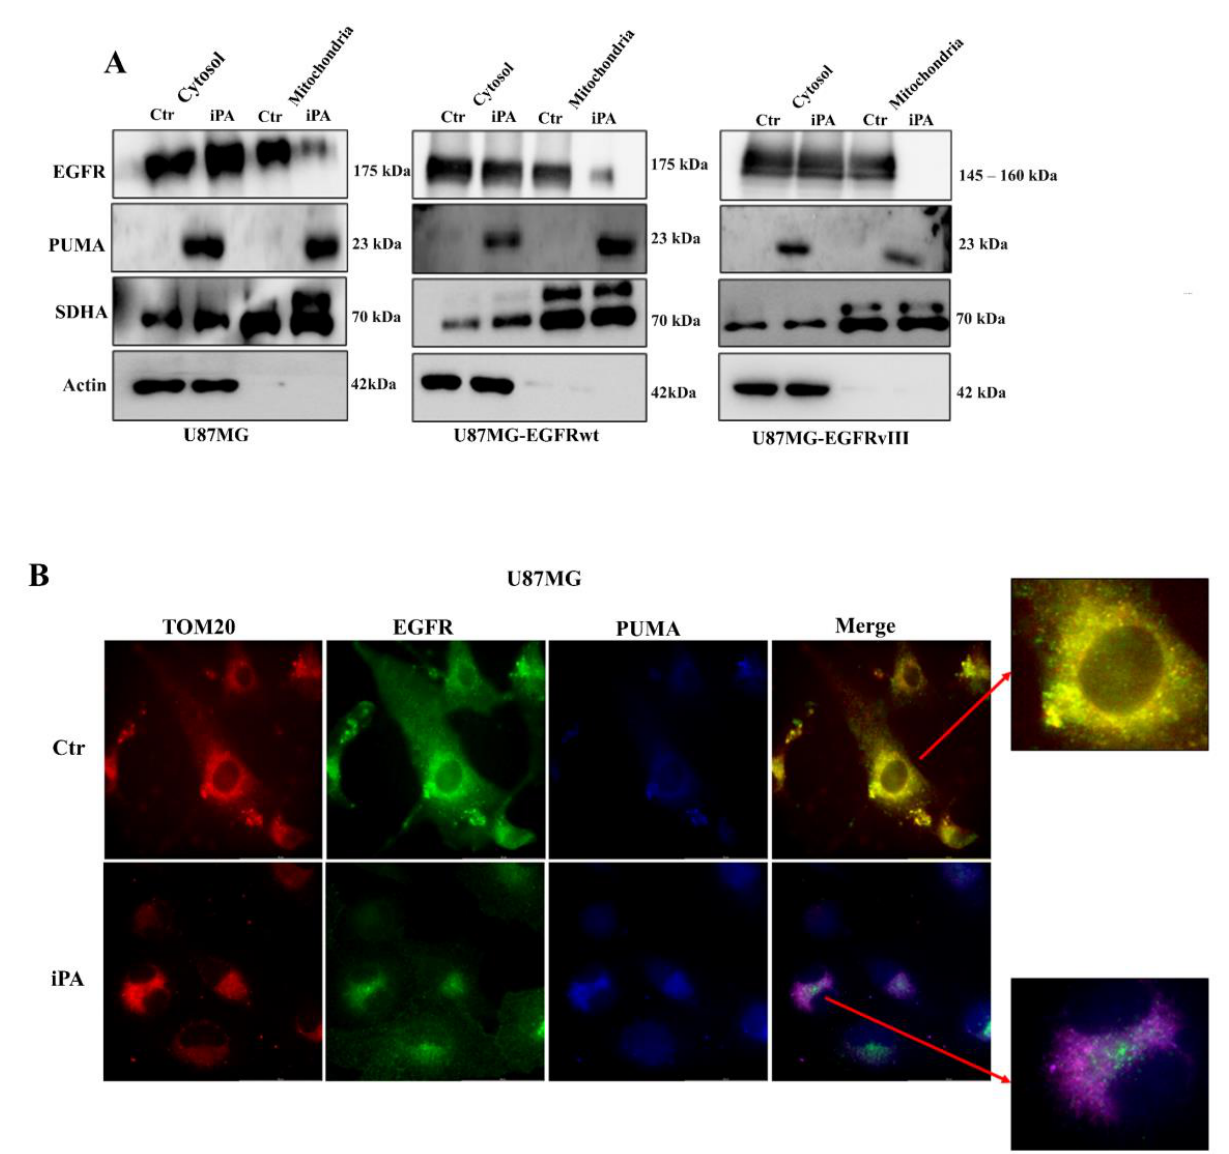
Figure 3. iPA inhibits the EGFR/EGFRvIII translocation on mitochondria in GBM cells. ( A ) Western blot showing the distribution of EGFR and PUMA levels in mitochondrial fraction and cytosolic fraction, showing the effects of iPA 10 µ M on EGFR and PUMA subcellular localization. ( B ) Immunofluorescence analysis of EGFR–PUMA localization in U87MG cells that had been treated and untreated with iPA 10 µ M. U87MG cells were stained with EGFR antibody (green) and PUMA antibody (blue), while the mitochondria were stained using the primary antibody TOM20 (red). The yellow color of merged imaged of Ctr show the co-localization of EGFR and TOM 20 (overlapping od red+ green signals; red arrow indicating the magnification marge image). The merged images of U87MG cells treated with iPA 10 µ M produced a violet color, suggesting a co-localization of TOM20 and PUMA (overlapping of red + blue signals; red arrow indicating the magnification marge image). Data are from three independent experiments that were conducted in technical replicate. Data are expressed as mean ± SEM. Data were analyzed for statistical significance using the 2-tailed Student t -test or ANOVA, followed by Bonferroni correction for multiple comparisons. Results are representative of 3 experiments performed in duplicate and are expressed as mean ±